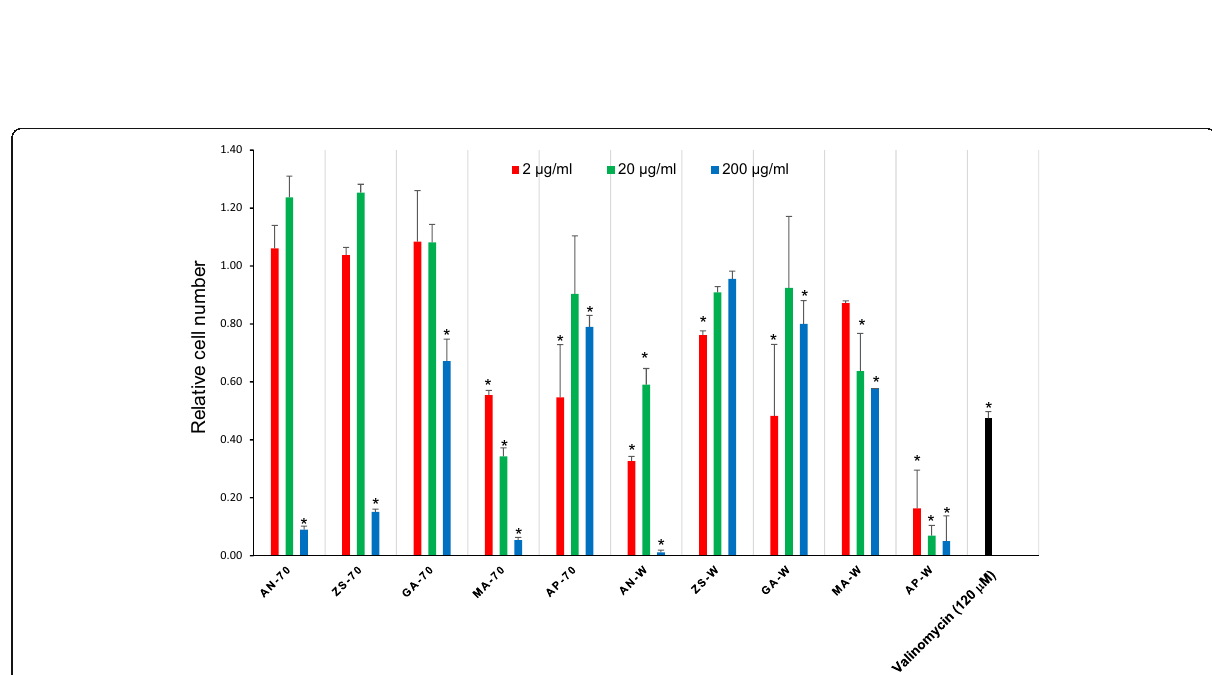
Fig. 1 Imaging of genotoxicity of Sudanese medicinal plants in HeLa cells using the HCS DNA Damage Kit, ( a ) Chart showing the relative genotoxicity level of the 70% ethanol and water extracts of five Sudanese medicinal plants (AN: Acacia nilotica , ZS: Ziziphus spina-christi , GA: Geigeria alata. MA: Martynia annua AP: Abrus precatorius ; For each extract, 70 represents 70% EtOH extract and W represents water extract), ( b ) Cells treated with 70% ethanolic extracts; ( c ) Cells treated with water extracts; ( d ) Positive control experiment, HeLa cells were treated with 120 μ M valinomycin for 24 h at 37 °C/5% CO 2 . Imaging and analysis were performed using a BZ-X700. At 120 μ M valinomycin, cells showed genotoxic effects as demonstrated by the positive pH2AX. The level of genotoxicity in the control experiment was set as 1.0. The fold change in signal between treated samples and control was >3-fold for a parameter indicating genotoxicity